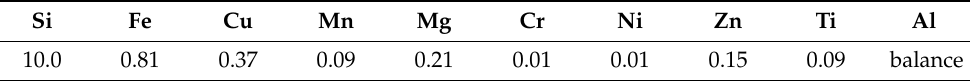
Table 1. Chemical composition of the EN AC–AlSi11(Fe) alloy, weight percentage.